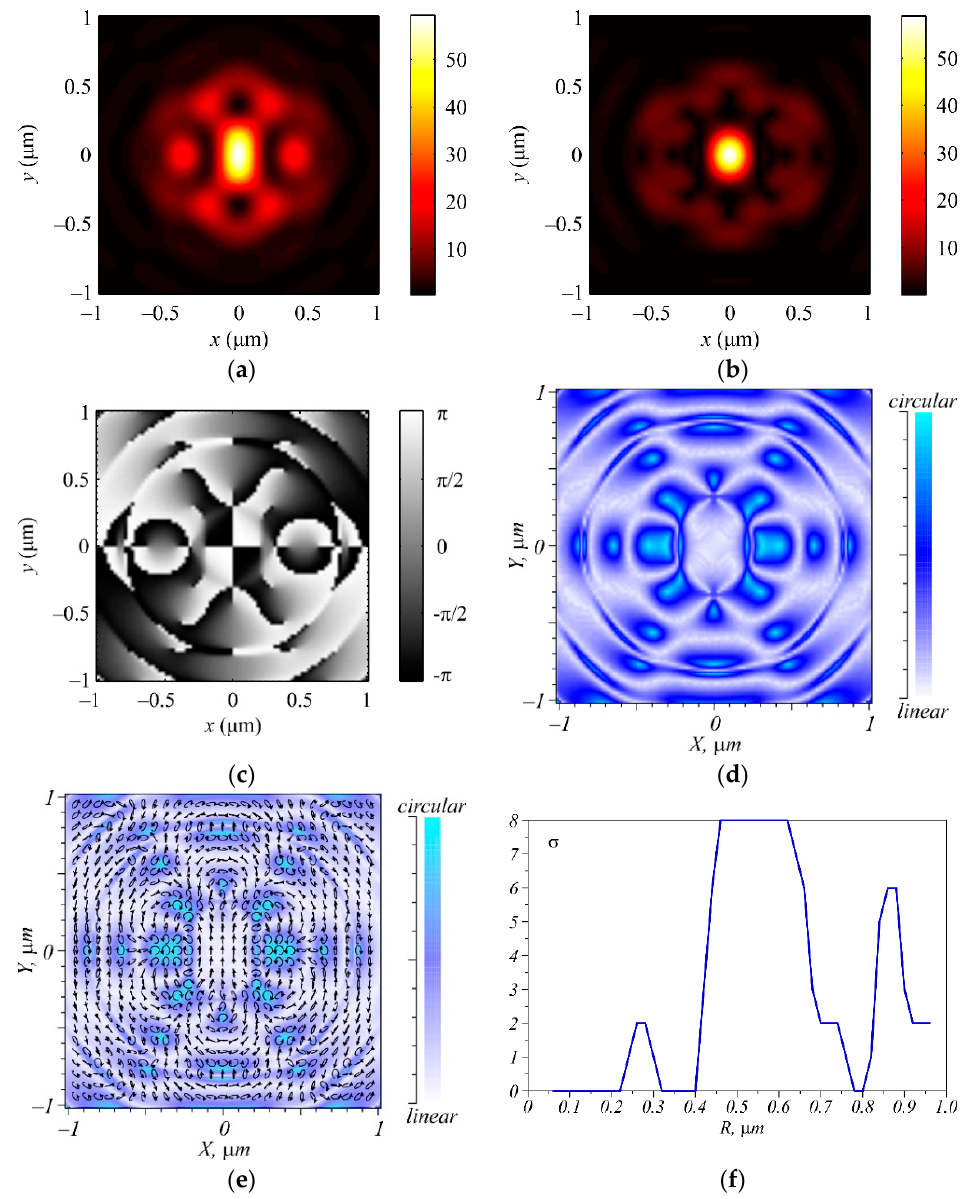
Figure 4. ( a ) An intensity I = Ix + Iy + Iz , ( b ) amplitude, and ( c ) phase of the complex Stokes field (20) when focusing field (1) at n = 4. ( d ) Pattern of points characterized by circular, elliptic, and linear polarization at the focus, ( e ) pattern of the elliptical polarization in focus and ( f ) dependence of the Stokes index σ on the radius R of the circle on which it is calculated (1 µm frame size). From Figure 4e,d, the C-points are seen to lie on the Cartesian axes and two